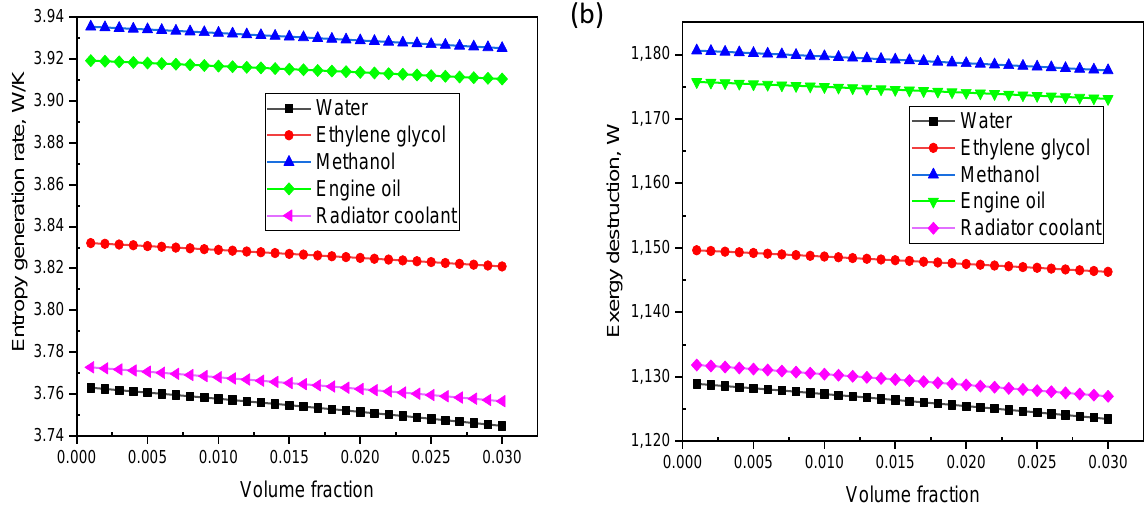
Figure 2. Effect of nanoparticles volume fraction on ( a ) entropy generation rate and ( b ) exergy de- struction.